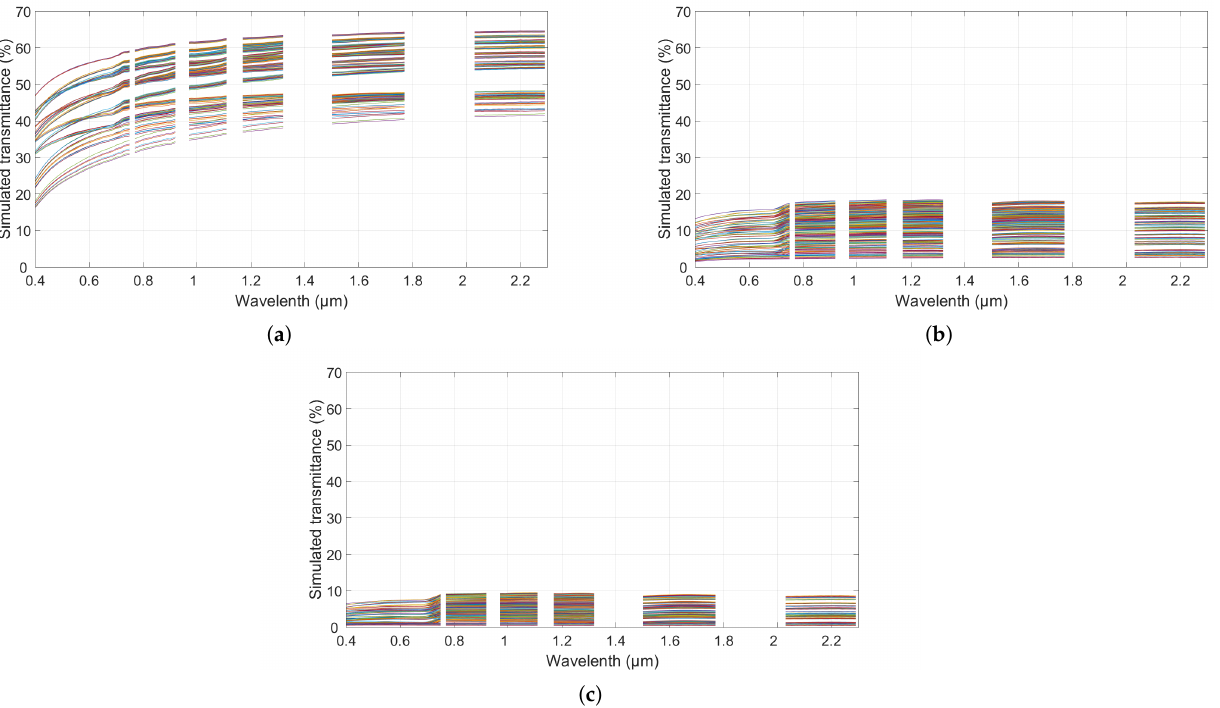
Figure 2. This is a wide figure. Figure 6. Spectral variations of the tree crown transmittance for LAI equal to ( a ) 1 m 2 .m − 2 , ( b ) 3 m 2 .m − 2 and ( c ) 6 m 2 .m − 2 for the empirical tree